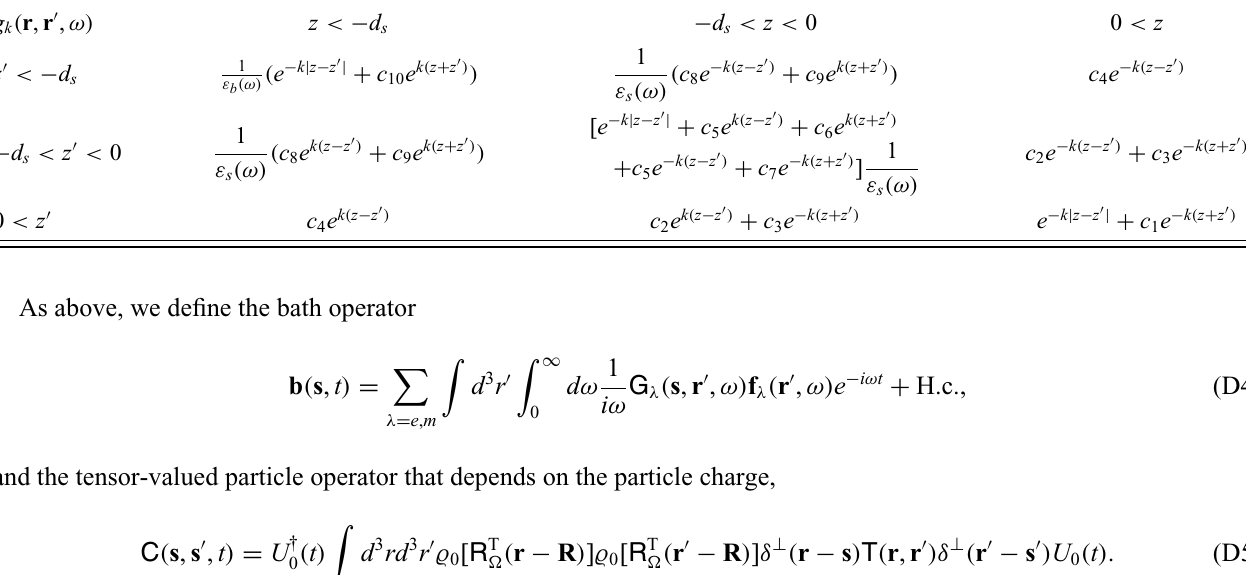
TABLE IV. The Green function for a geometry consisting of a vacuum half-space with ε r ( r , ω) = 1 for 0 < r · e 3 , a dielectric layer with ε r ( r , ω) = ε s (ω) for − d s < r · e 3 < 0, and a dielectric half-space with ε r ( r , ω) = ε b (ω) for r · e 3 < − d s . For the table, we defined z = r · e 3 and z (cid:3) = r (cid:3) · e 3 . For the dependence of the Green function on g k ( r , r (cid:3) , ω) , see Eq. (C24). g k ( r , r (cid:3) ,